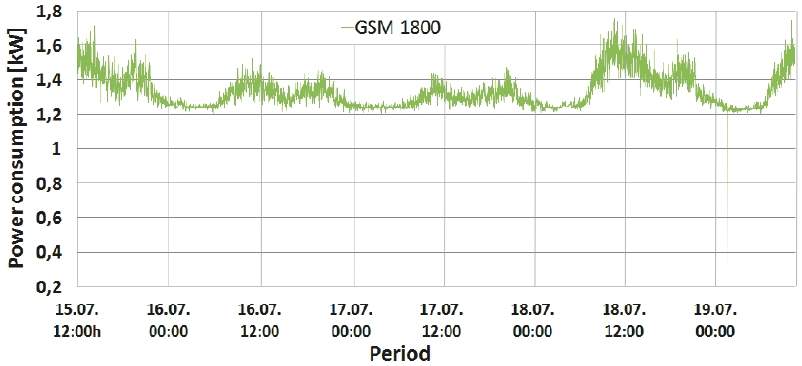
Figure 6. Power consumption of GSM 1800 BS cabinet.